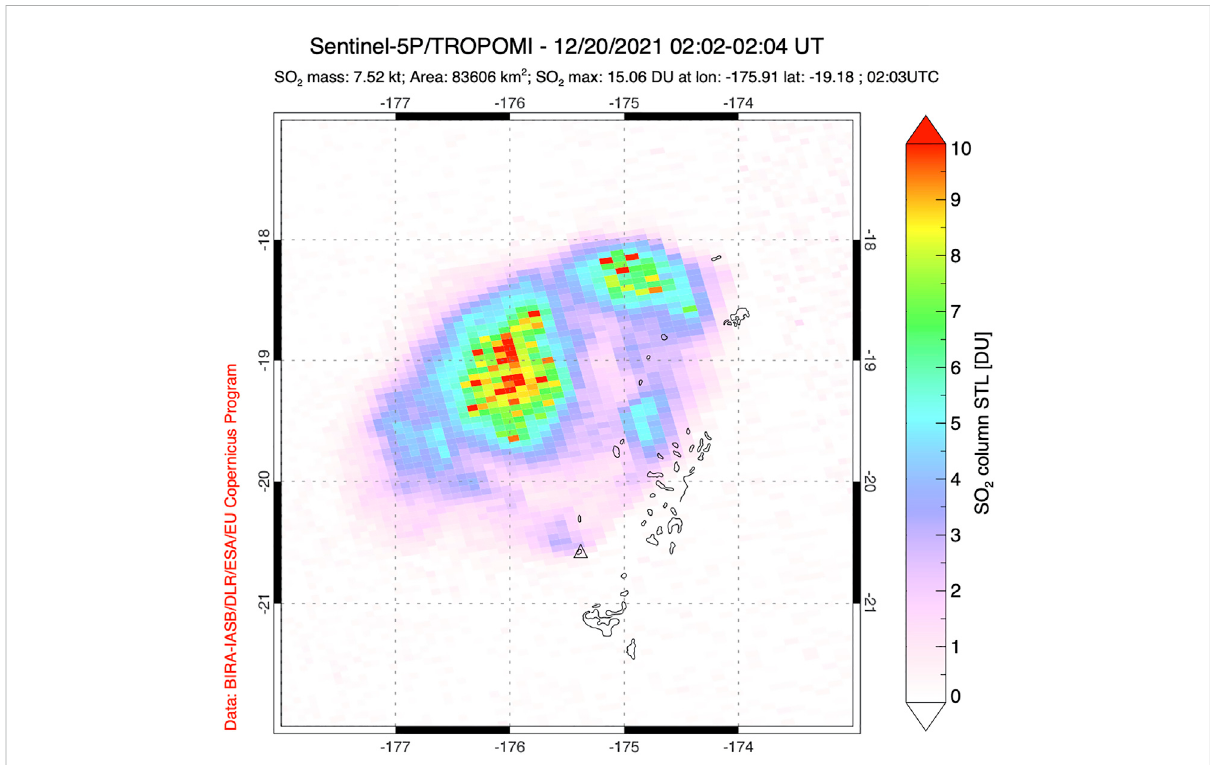
FIGURE 2 Lower stratospheric (STL) SO 2 columns measured by S5P/TROPOMI in the volcanic cloud produced by the eruption of HTHH at 20:35 UTC on 19 December 2021. The S5P/TROPOMI overpass was ~5.5 h after the eruption at 02:03 UTC on December 20. The retrieved SO 2 columns ( < 10 DU) and the total SO 2 mass (8 kilotons; ~0.01 Tg) are both relatively low for a fresh, upper tropospheric volcanic cloud. Scale: 1 ° in latitude/longitude corresponds to a distance of ~100